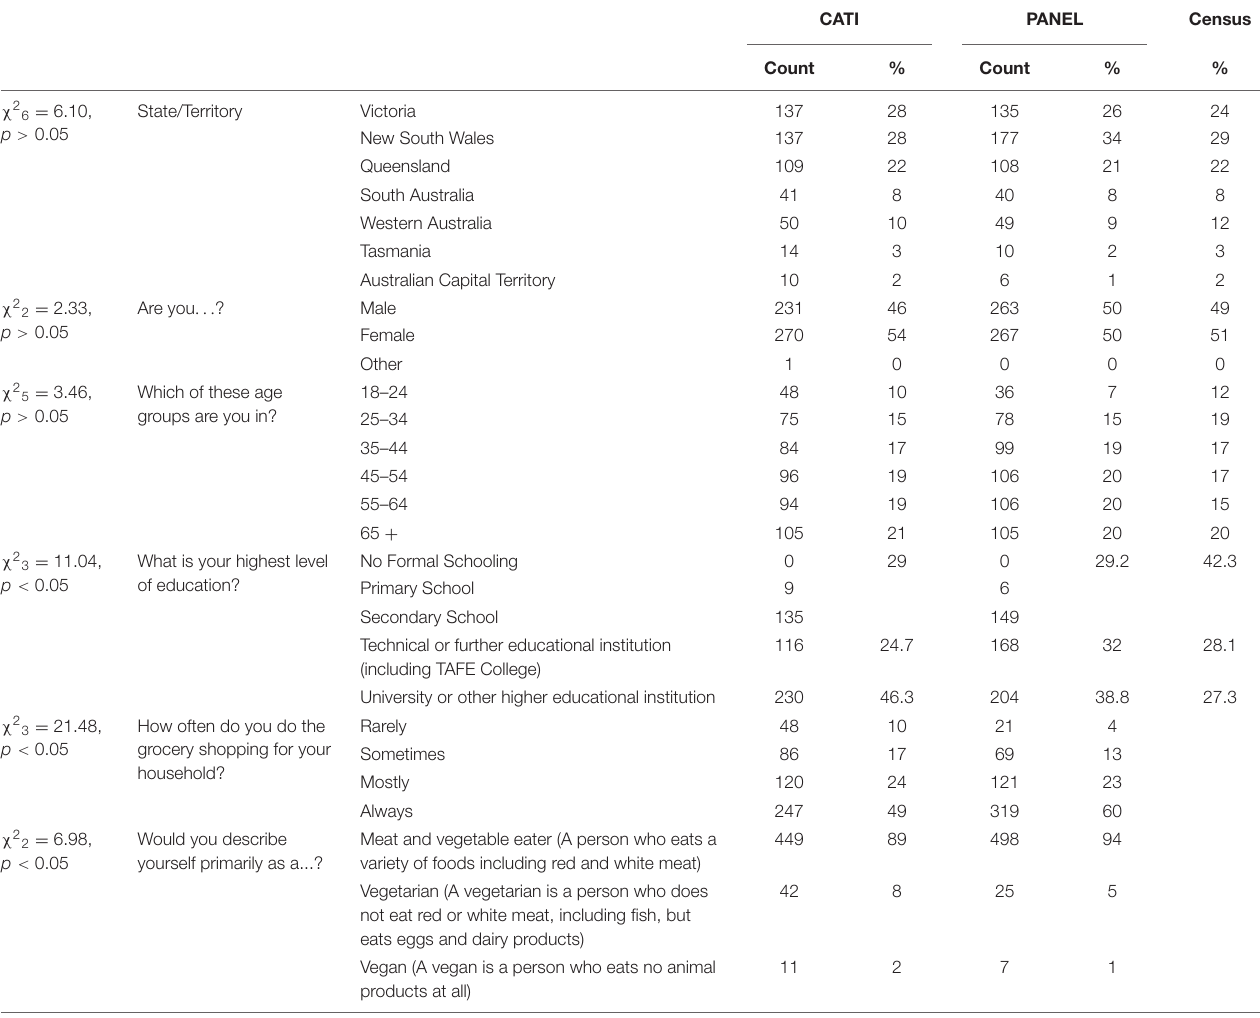
CATI PANEL Census Count % Count % %